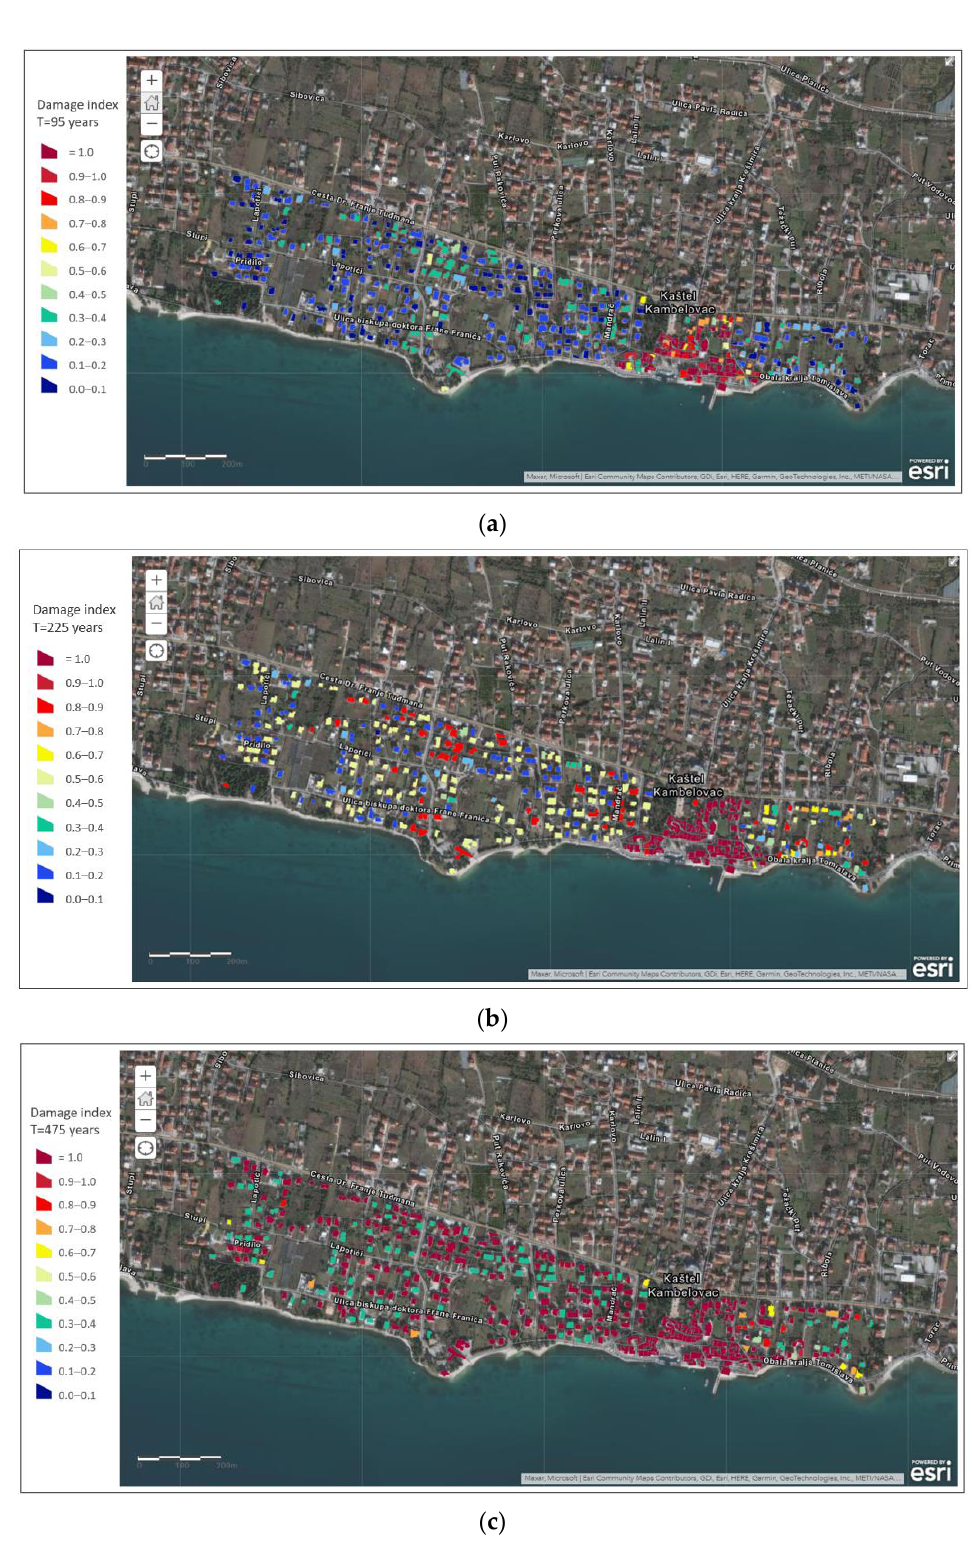
Figure 17. Damage index distribution at the test site: ( a ) T = 95 years; ( b ) T = 225 years; ( c ) T = 475 years.